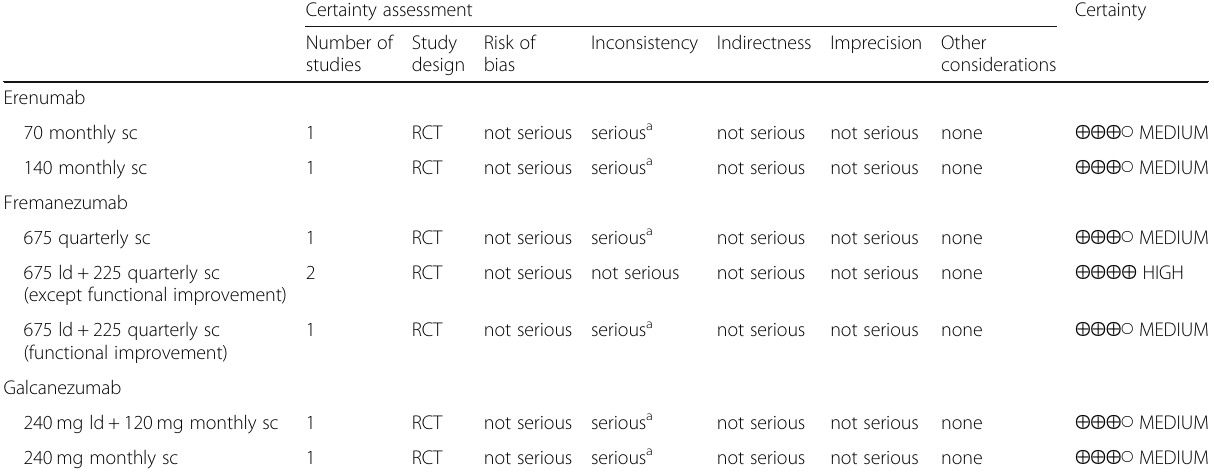
Table 4 Certainty in the assessment of efficacy outcomes for anti-calcitonin gene-related peptide monoclonal antibodies for prevention in chronic migraine Certainty